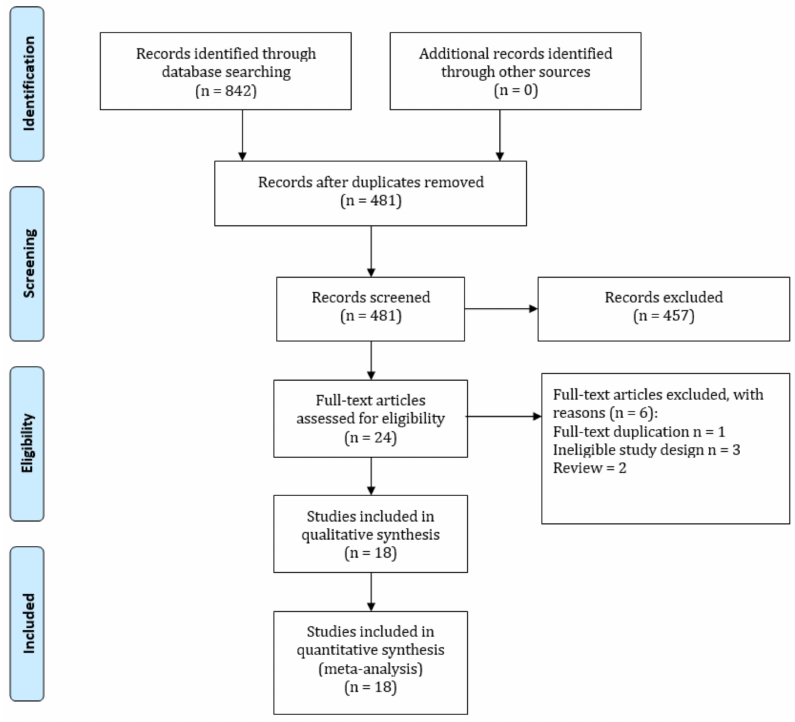
Figure 1. PRISMA diagram of the study selection process.